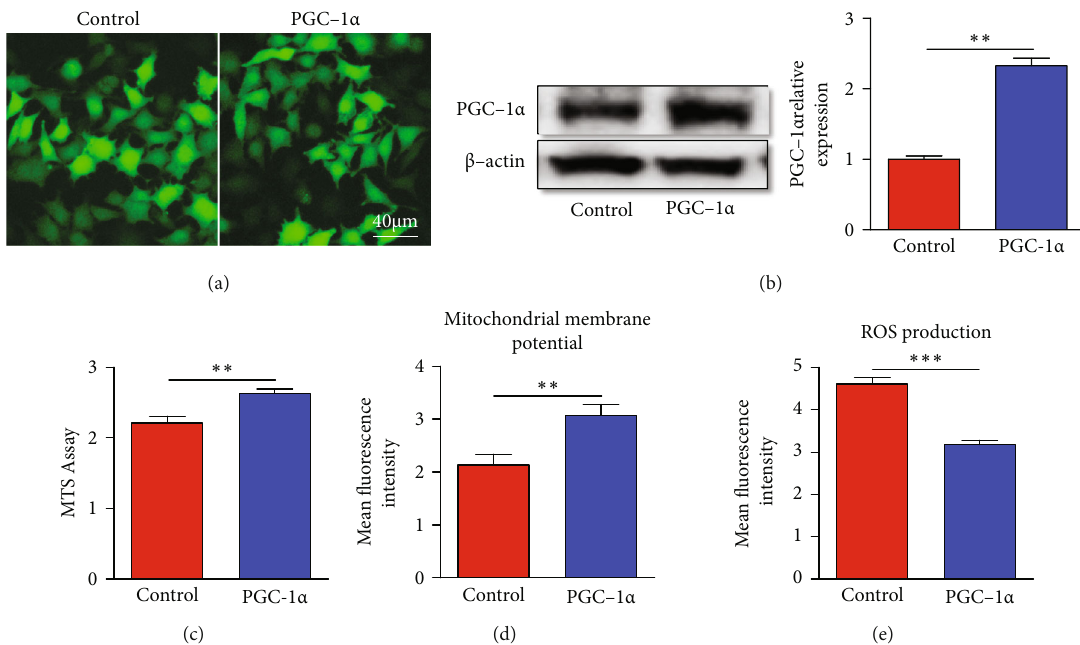
Figure 1: PGC-1 α protect against OGD-induced hippocampal neuron damage. (a) Representative images of EGFP expression in HT-22 cells after lentivirus transfection. (b) Western blot showing PGC-1 α expression in control group and PGC-1 α group (left panel). The relative expression of PGC-1 α was measured using ImageJ software (right panel). (c) MTS analysis showing the e ff ect of PGC-1 α on viability of HT-22 cells. (d) The evaluation of PGC-1 α on mitochondrial function re fl ected by mitochondrial membrane potential. (e) Quantitation of ROS production in HT-22 cells after OGD treatment. ∗∗ p < 0 : 01, ∗∗∗ p < 0 : 001 ; n = 5 -10 per